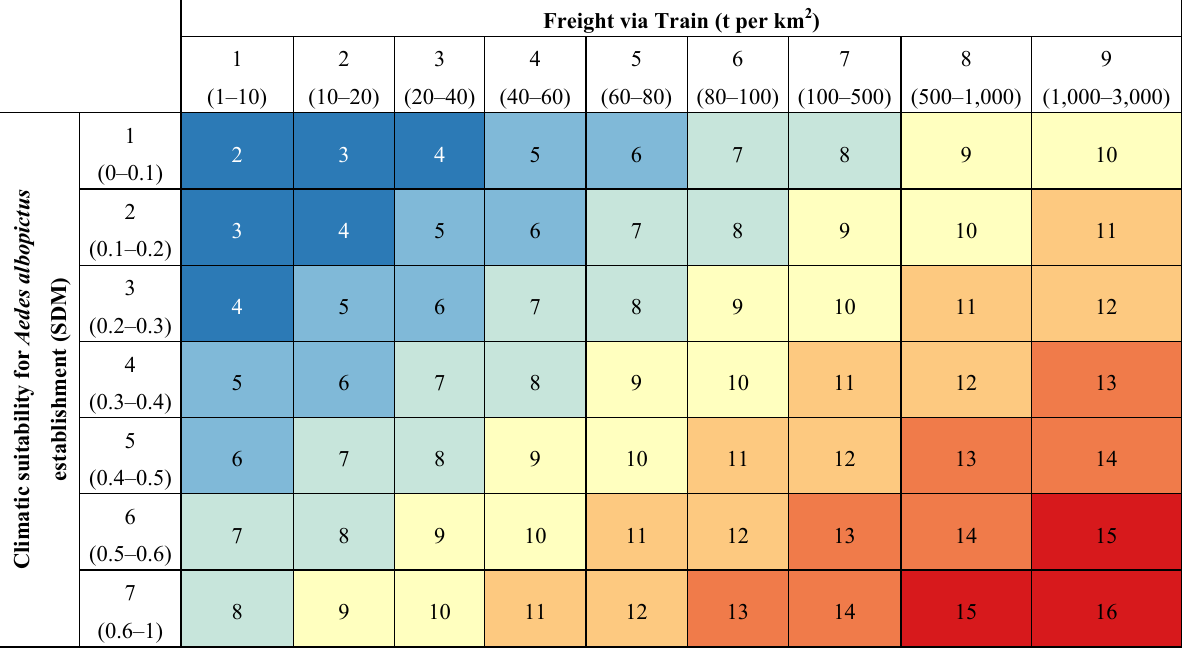
2. Combined risk evaluation taking into account climatic suitability for Aedes albopictus establishment and received freight per area via railway